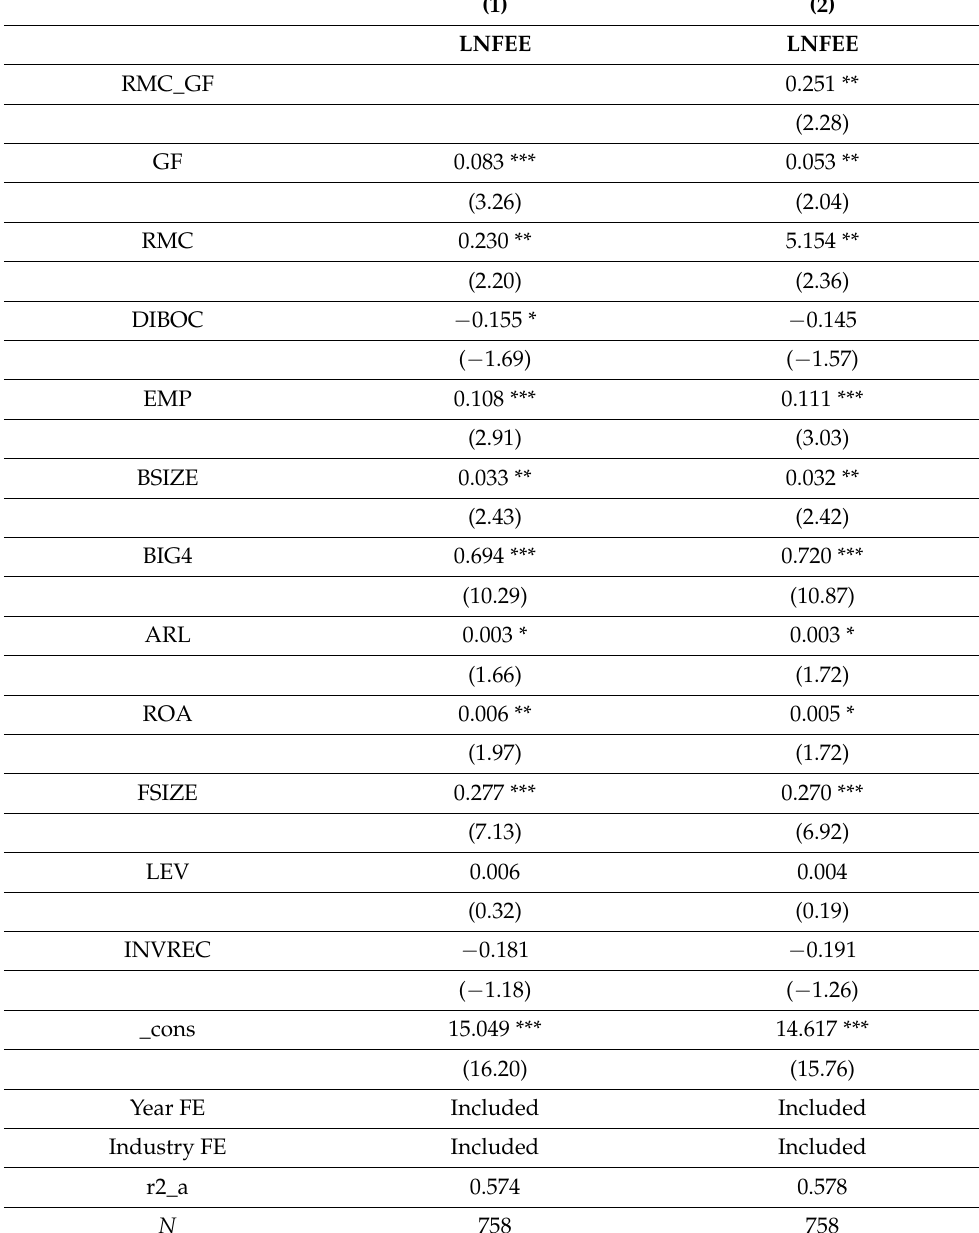
Table 7. Moderated regression